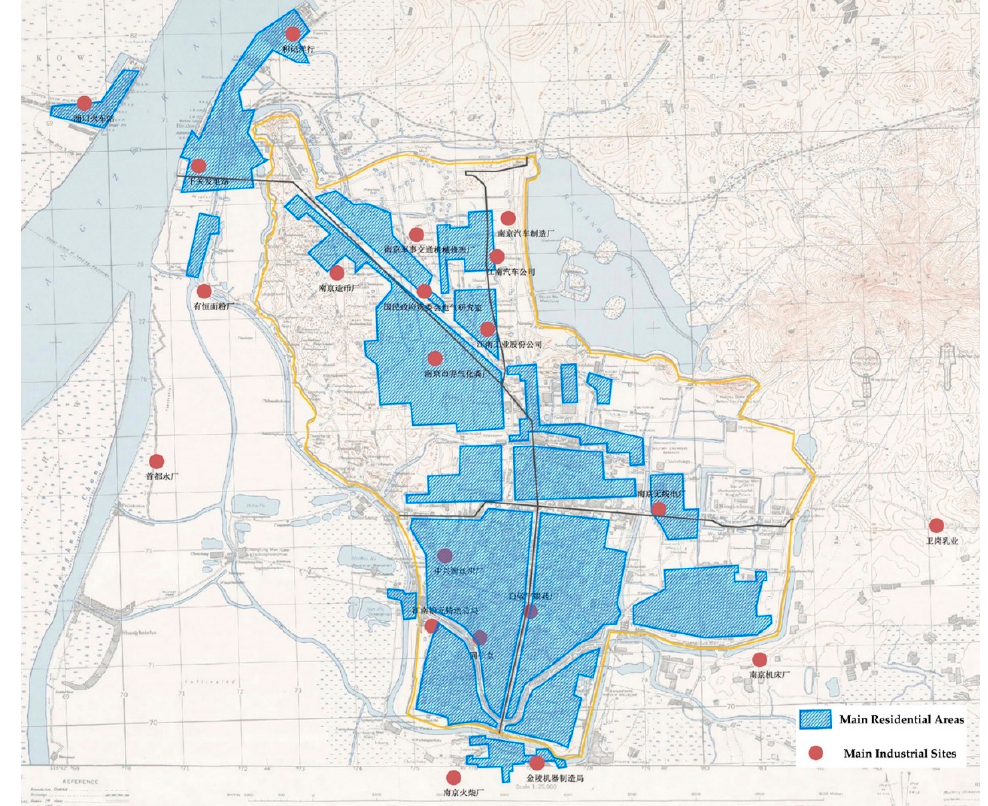
Figure 7. Population distribution of Nanjing in 1945 (blue) and main industrial sites (red dot) (Figure from: [15]; data from: Nanjing Archives).